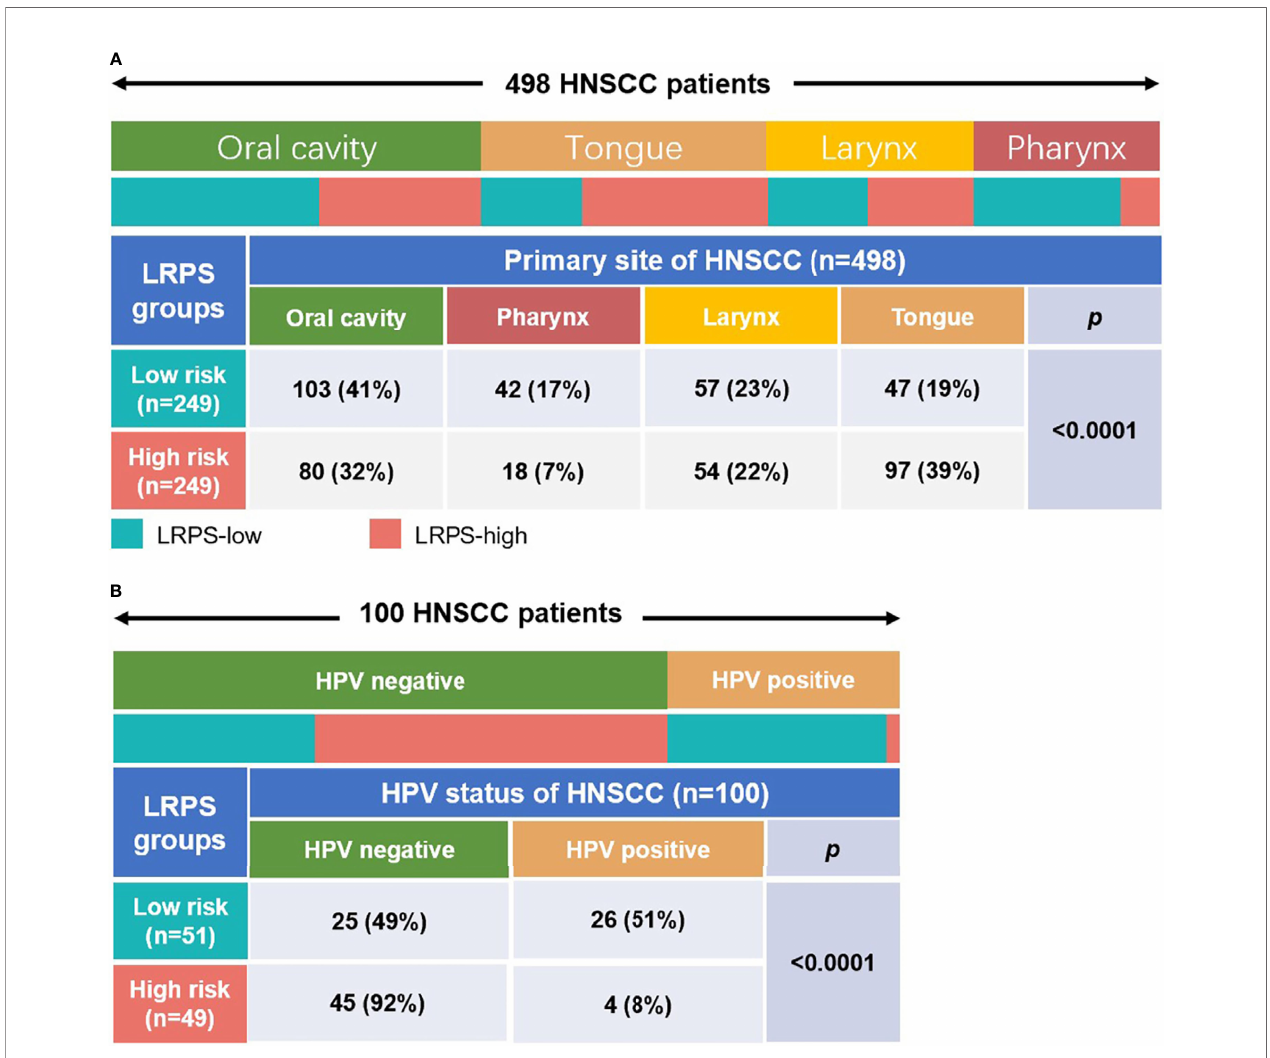
FIGURE 6 | Distribution of primary tumor sites and the HPV status in different LRPS subgroups. (A) Heatmap and table showing the distribution of HNSCC primary sites (oral cavity, pharynx, larynx, and tongue) between the LRPS subgroups. (B) Heatmap and table showing the distribution of different HPV status between the two LRPS subgroups. The distributions of the primary site subtypes and HPV status in the LRPS subgroups were compared through the Fisher